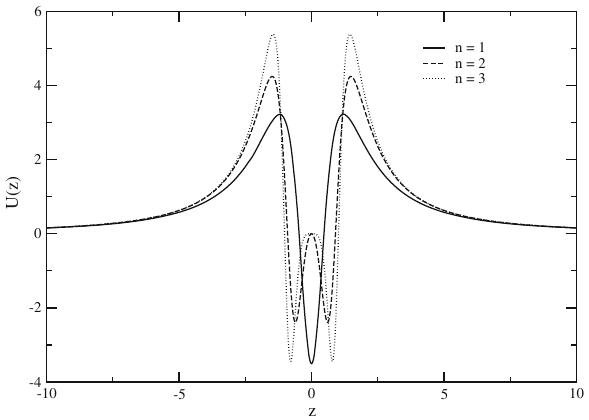
Fig. 3 Schrödinger’s potential for KR field in smooth scenario gen- erated by domain walls for Ricci tensor coupling with some values of parameter n and k = 1